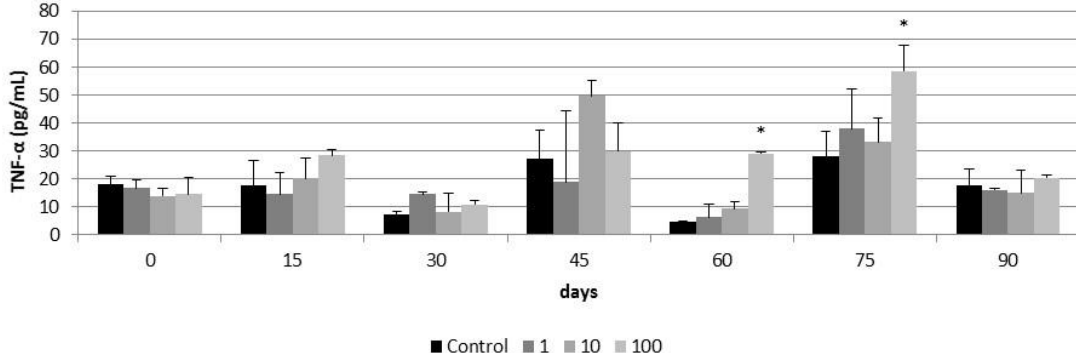
Figure 12. TNF- α release in control airway epithelia and in airway epithelia exposed for 90 days to different concentrations of CeO 2 -NPs (1, 10, and 100 µg/cm 2 ). Exposures were performed every two weeks for three months. Results are expressed as means ± SD of five replicates per tested condition and one assay ( n = 5). Asterisks indicate significant differences with respect to the untreated control cells ( p < 0.05).